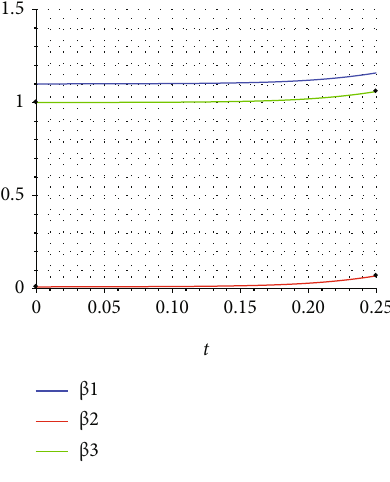
Figure 1: Graphs in ½ 0, 1/4 (cid:2) .